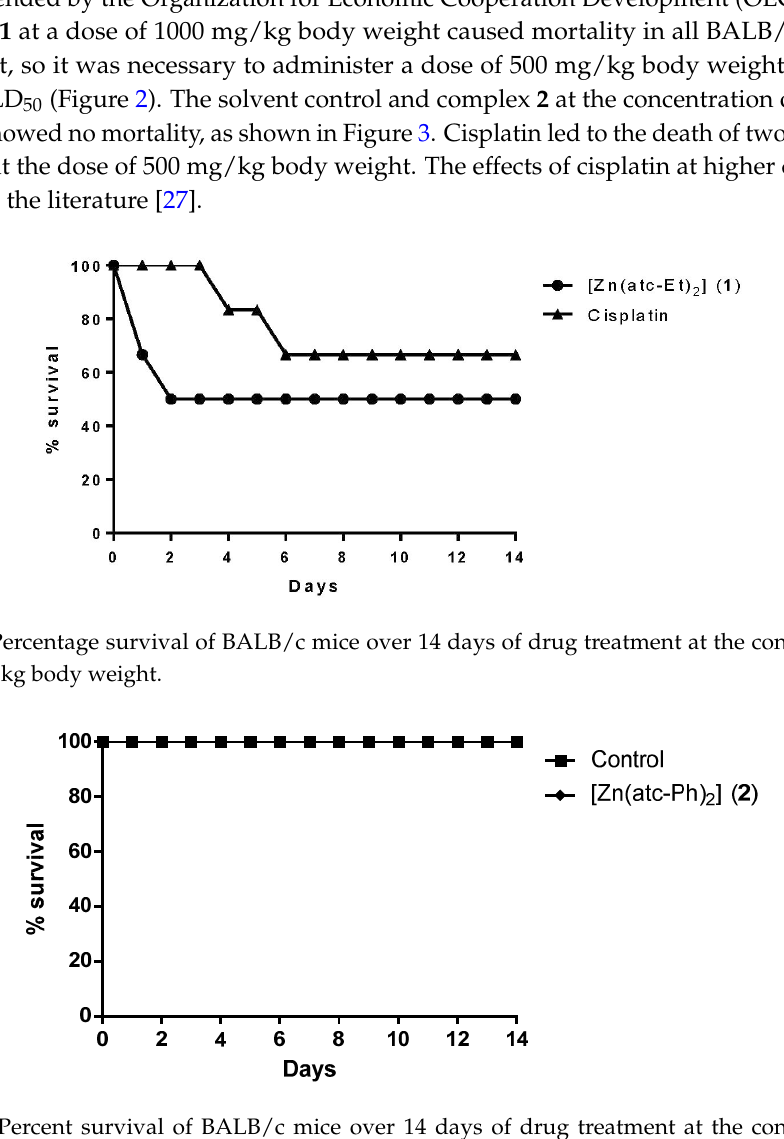
Figure 3. Percent survival of BALB/c mice over 14 days of drug treatment at the concentration of 1000 mg/kg body weight.